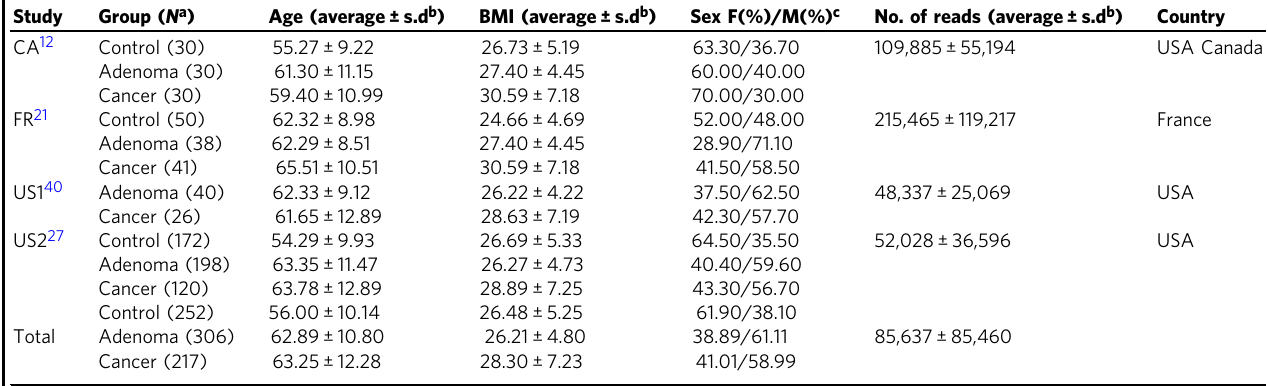
All data sets were sequencing data of the V4 region of the 16S rRNA gene. a Number of